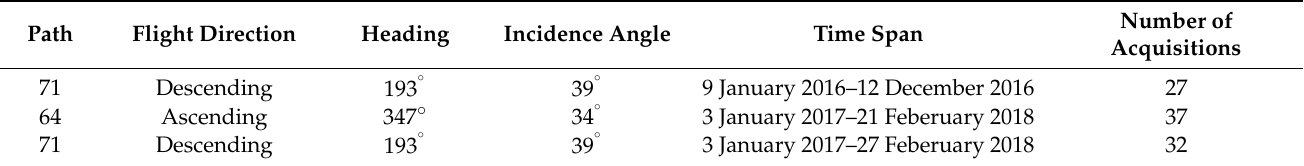
Table 1. Data used in the PSInSAR TM